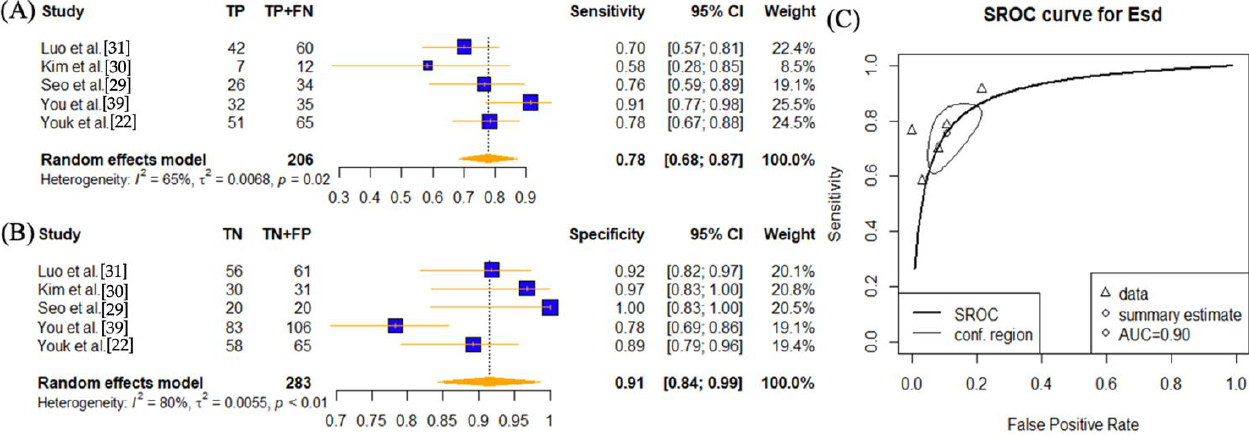
Figure 5. Sensitivity and specificity forest plots and overall accuracy results of E sd . (( A – C ) Reported sensitivity and specificity values for E sd values per selected study with AUC value on SROC curve for the analysis of E sd . Forest plots for pooled sensitivities and specificities are displayed as diamonds in the graphs for E sd ( A , B ). The SROC curve indicates the summary estimates in circles (( C ) for E sd ). Triangles represent included study with dotted lines representing the confidence interval and solid line for the SROC. AUC value is displayed (in the legend). E sd — tissue stiffness standard deviation SWE parameter; AUC — area under the curve; SROC — summary receiver operating characteristic.